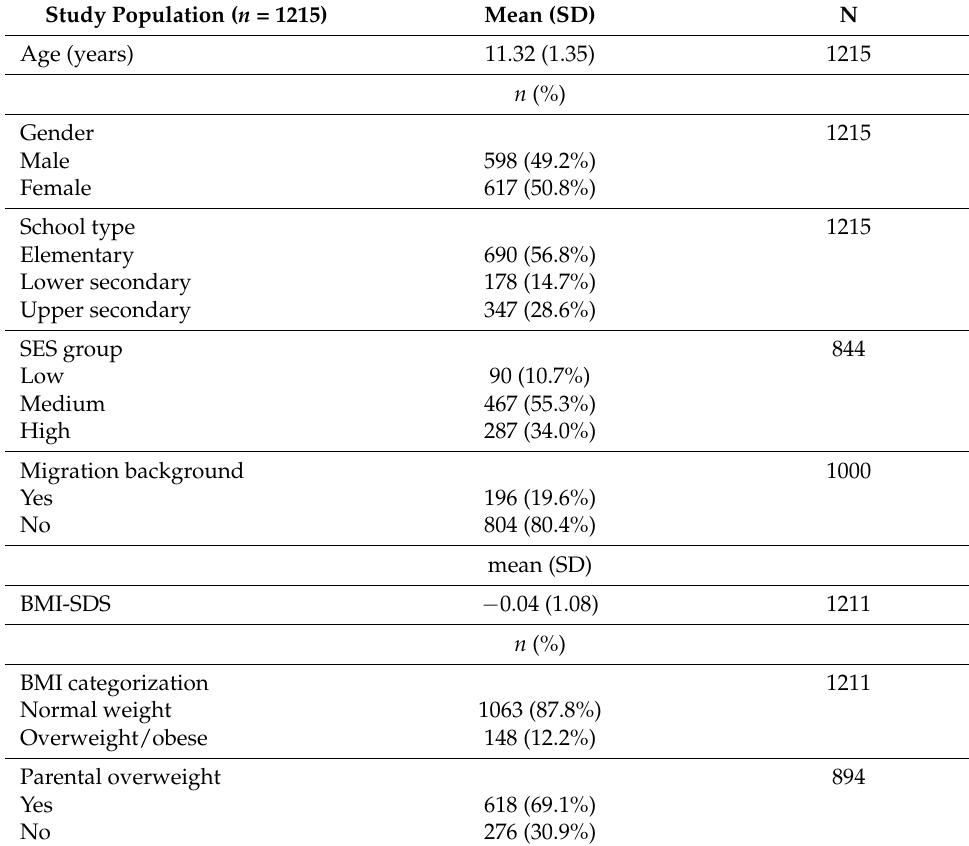
Table 3. Description of study sample. Descriptives are given as mean and standard deviation for continuous variables and counts and percentages for categorical